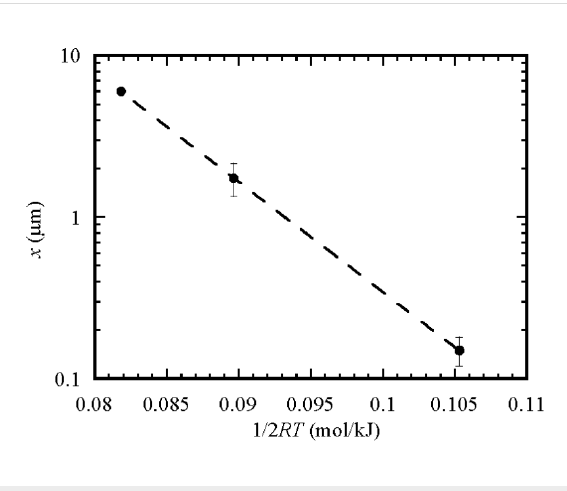
Figure 9: Temperature dependence of the migration distance of Ag atoms on the outmost surface of the TiO 2 nanotubes for a heat treat- ment of 2